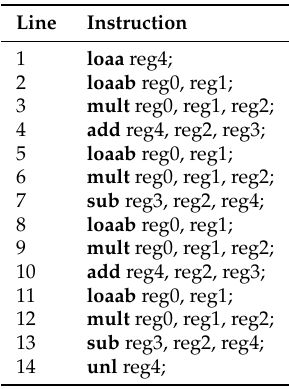
Table 7. Listing of code for discrete Green’s function (DGF) computations ( n = 4, k = 0). Line